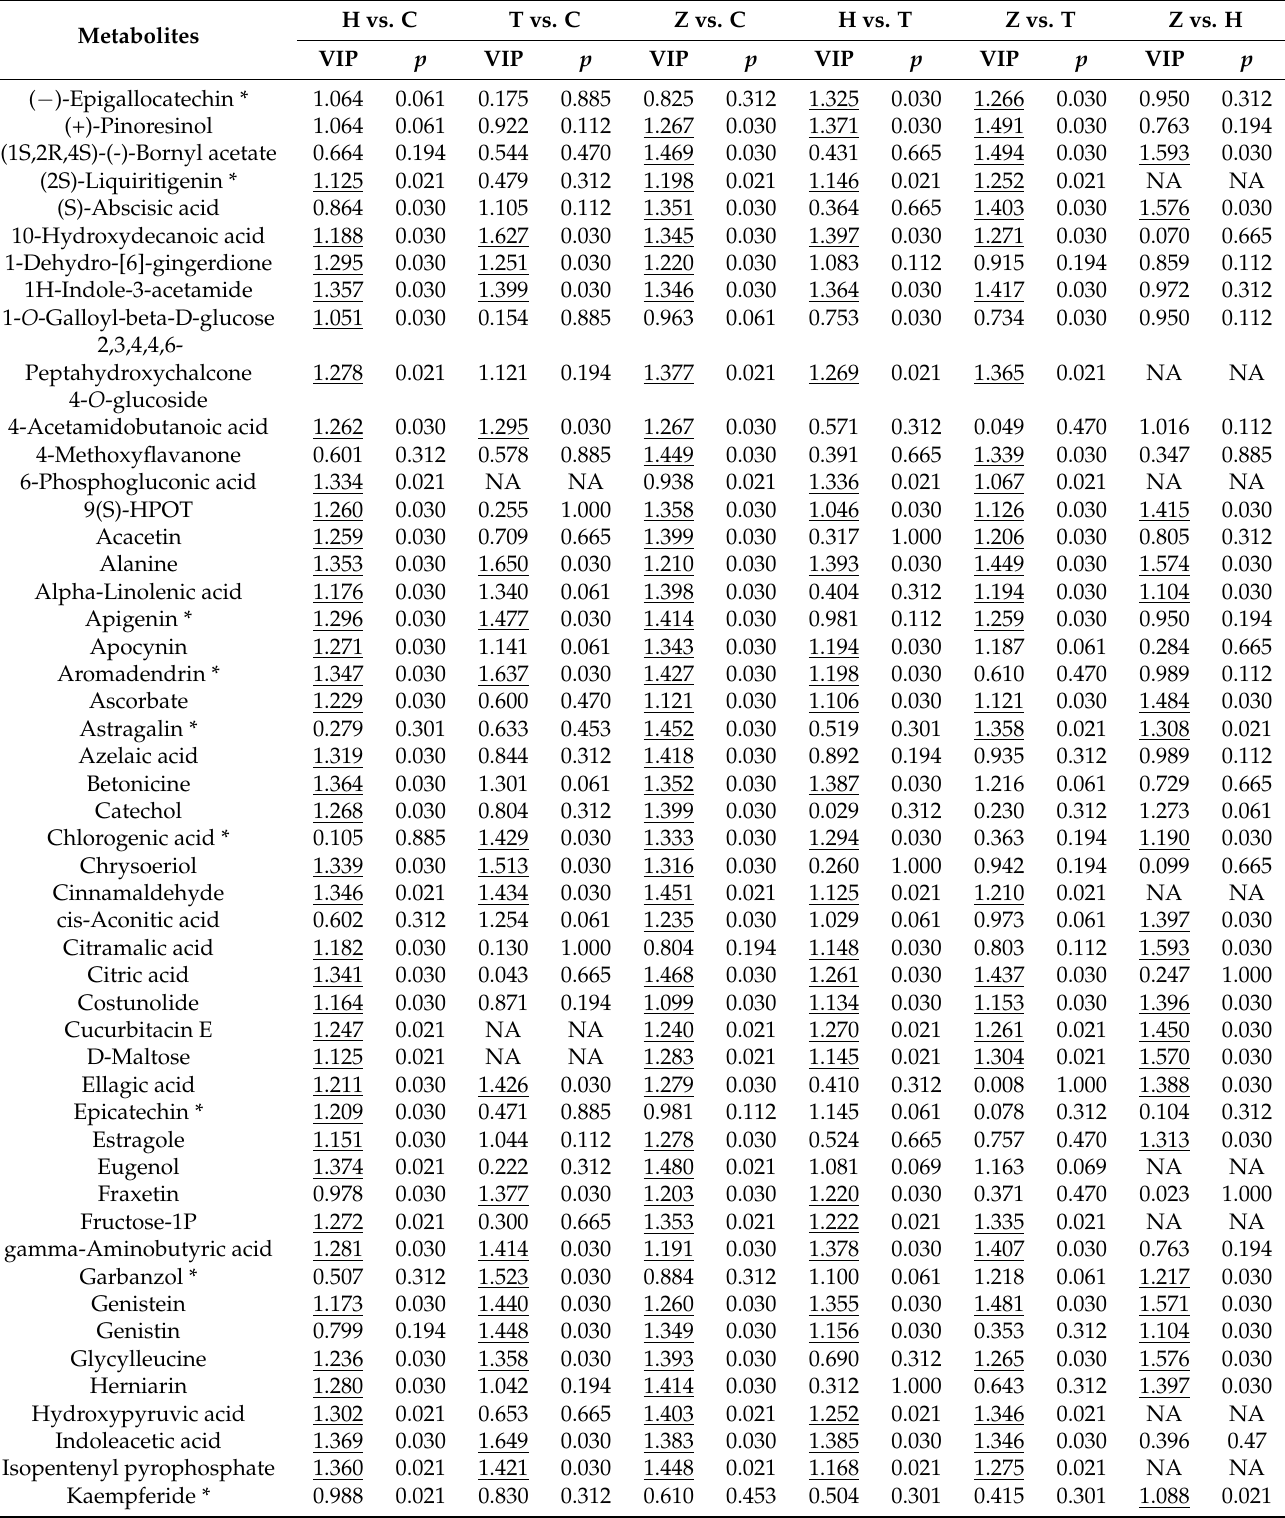
Table 1. Differential metabolites in the comparison of different